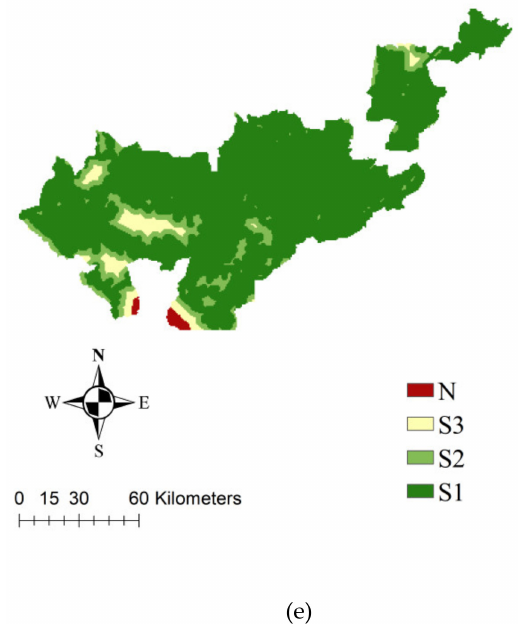
Figure 7. Reclassification of the criteria for the land suitability analysis to propose extension of potential forest areas. ( a ) Settlements, ( b ) LULC, ( c ) elevation, ( d ) distance from rivers, and ( e ) distance from roads.